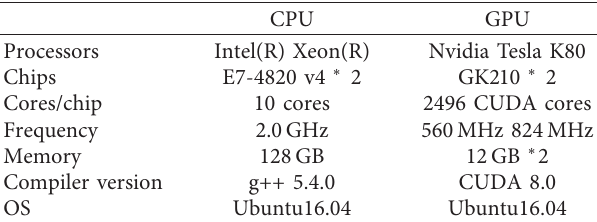
Table 2: Experiment